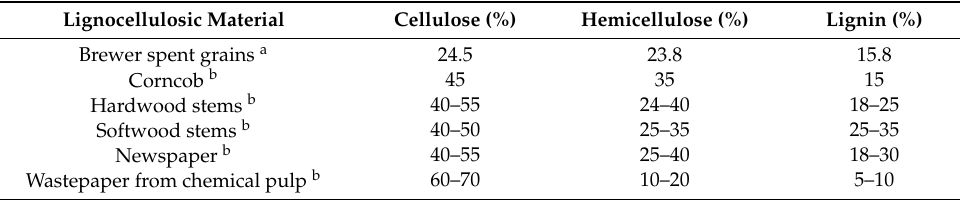
Table 1. Percentage of cellulose, hemicellulose, and lignin contents in selected agricultural residues and